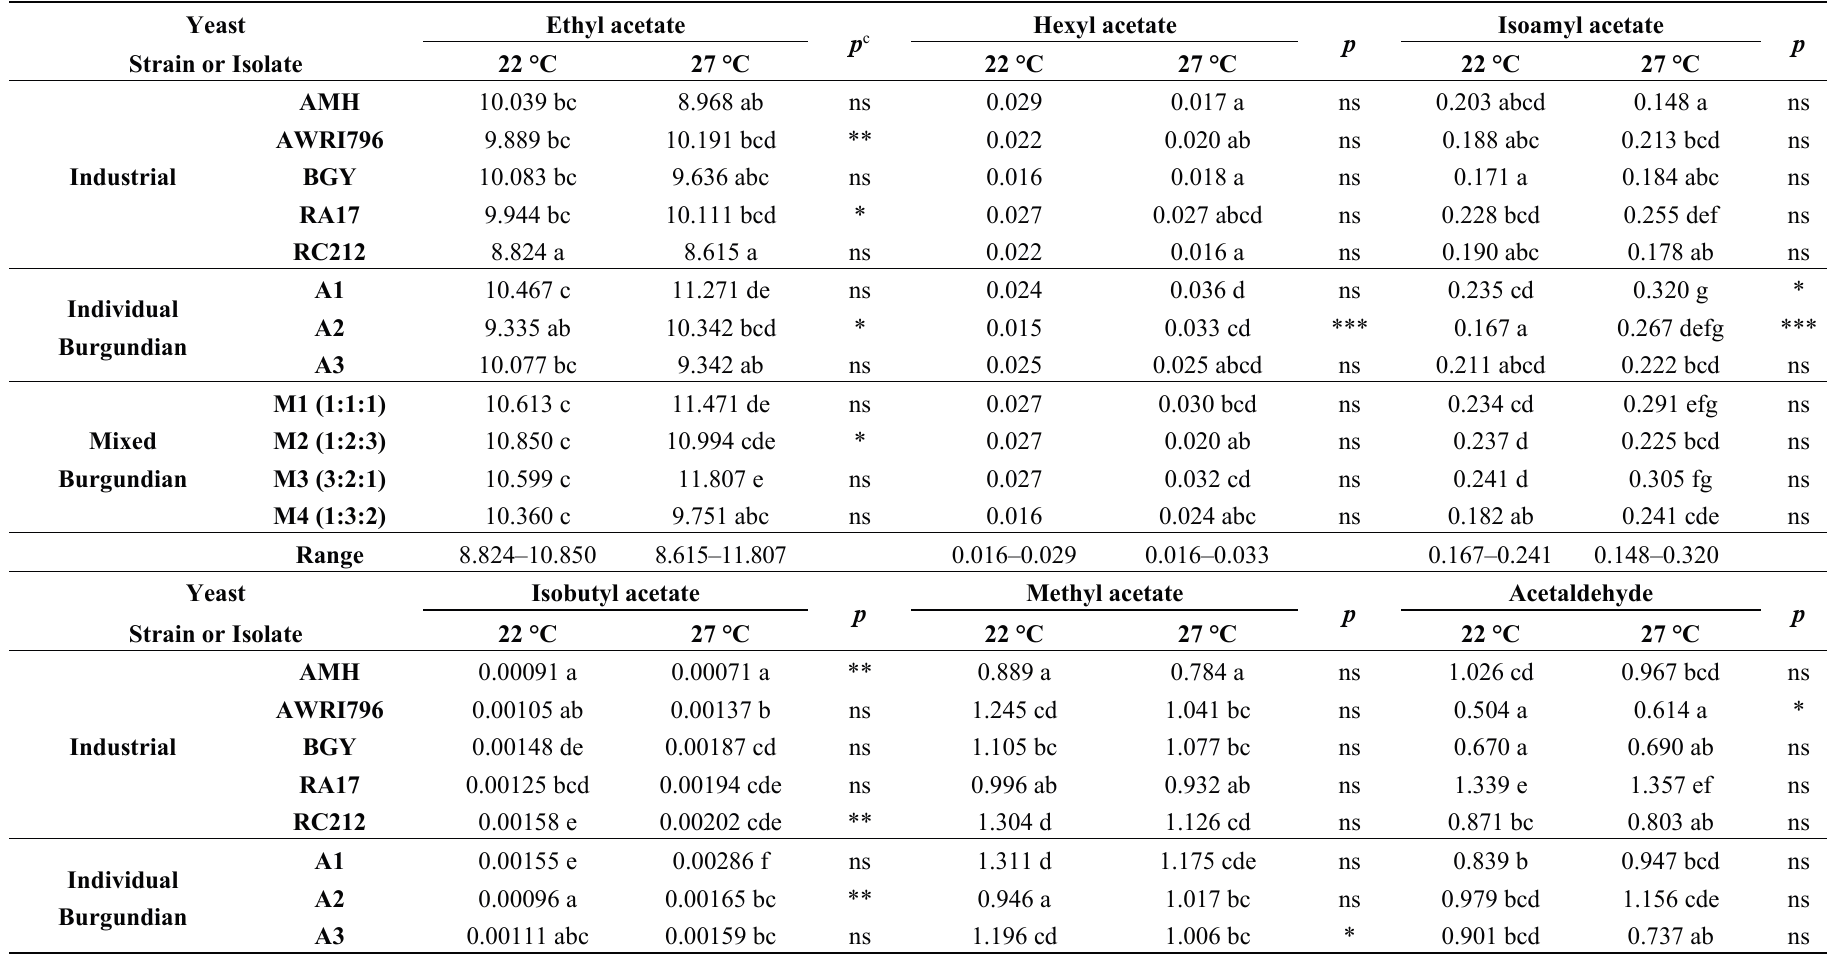
Table 4. Acetate esters, aldehydes, acid and acetal (mg·L − 1 ) a,b in Pinot noir fermented by industrial strains and individual- and mixed-Burgundian S. cerevisiae isolates, at 22 °C and 27 °C. For each determination, strain and temperature effects are shown with subscripts and p values, respectively.